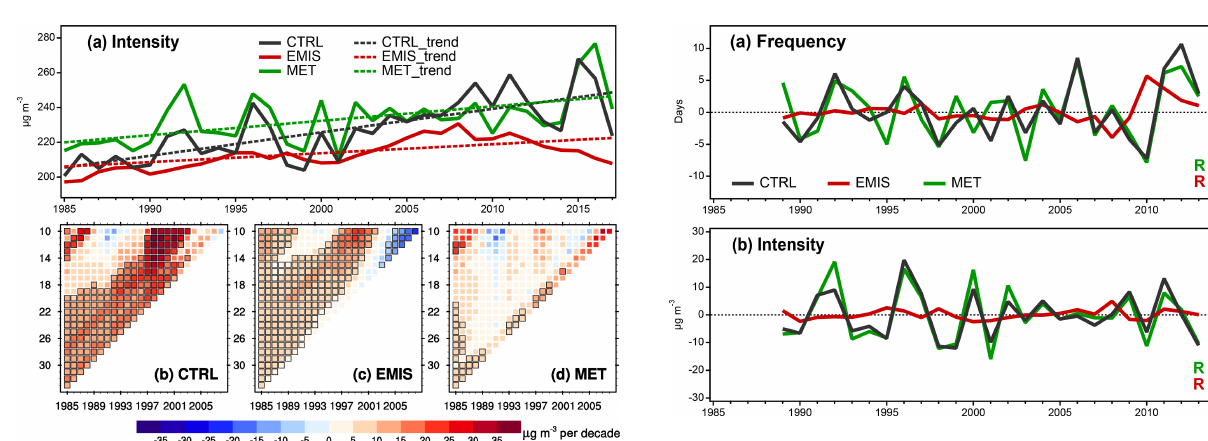
Figure 12. Interannual variations in SWHD (a) frequencies (days) and (b) intensities (µgm − 3 ) in BTH through a 9-year weighted moving average method. The nine-point high-pass Lanczos filter was used as the weighting coefficient, which effectively removes fluctuations with periods of more than 9 years and reserves the inter- annual anomalies. Also shown are the correlation coefficients that were calculated between the interannual signals of the CTRL and MET simulations (green R ) and between the results of the CTRL and EMIS simulations (red R